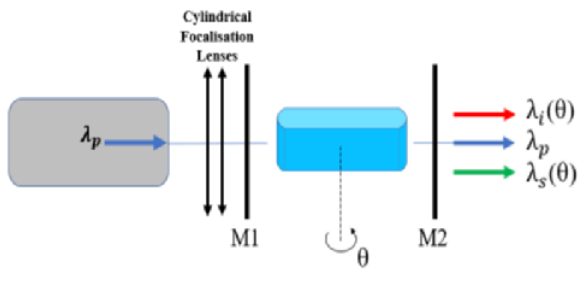
Fig. 3. OPO schematic layout. M stand for plane mirrors.